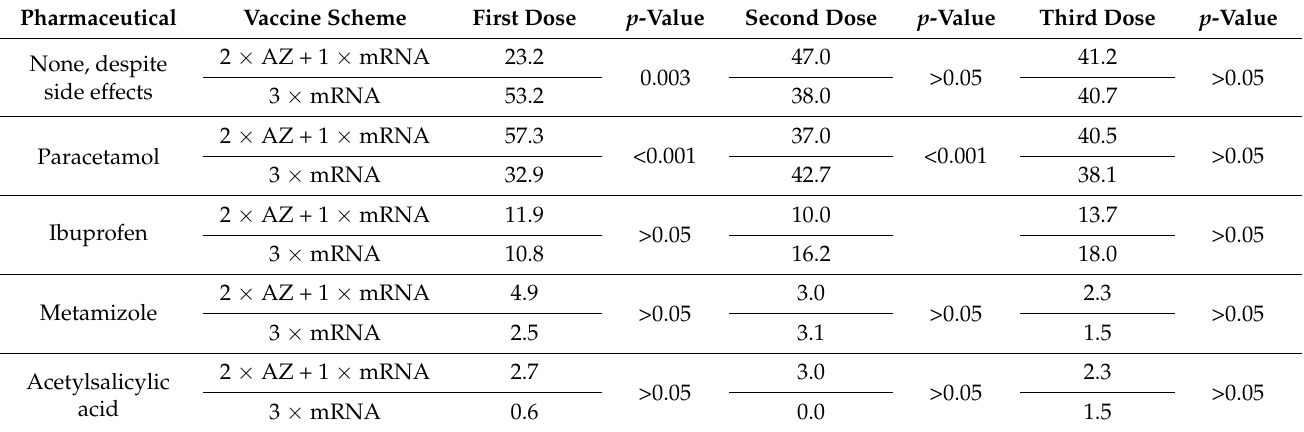
Table 4. The frequency of pharmaceutical use in individuals experiencing side effects after